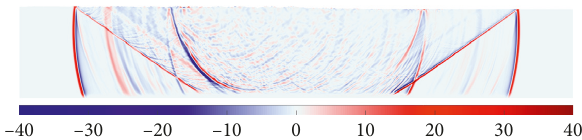
Figure 15: Velocity distribution in the x direction at time � 50s.